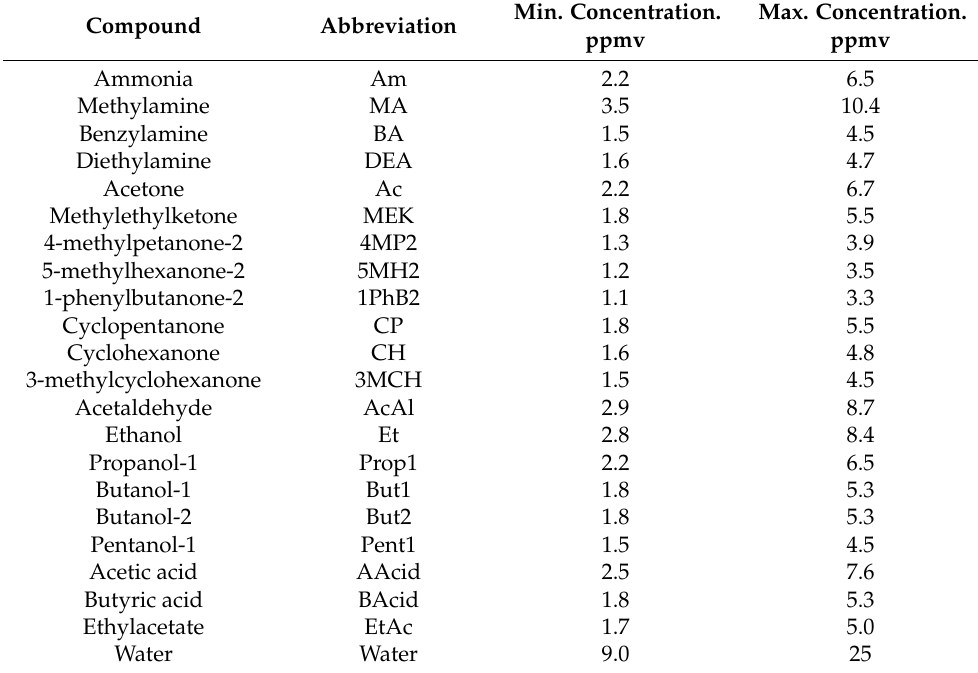
Table 1. Individual substances used for training the gas sensor array and their concentrations ranges.